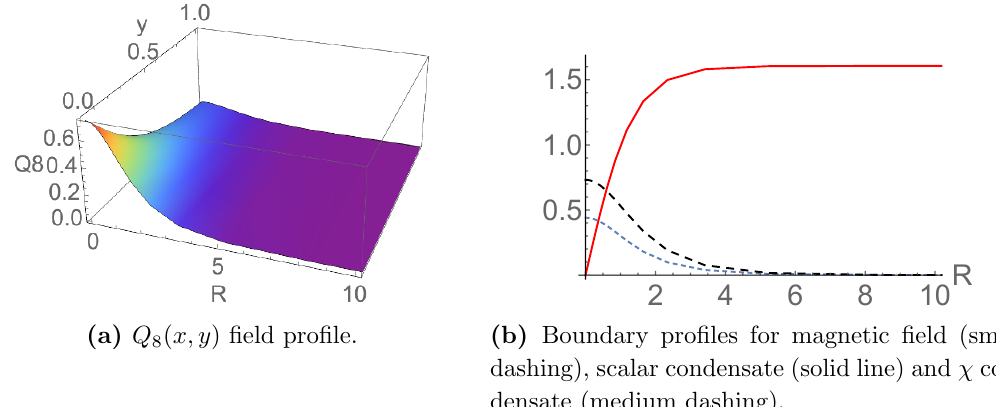
Figure 3. Solutions of the gravitating non-abelian vortex at, q = L = n = 1, (cid:20) = (cid:0) 1, ~ (cid:20) = 2 (cid:20) , y + = 1 = 2, (cid:13) = 3, (cid:12) = 1, plotted as a function of the physical radial coordinate R